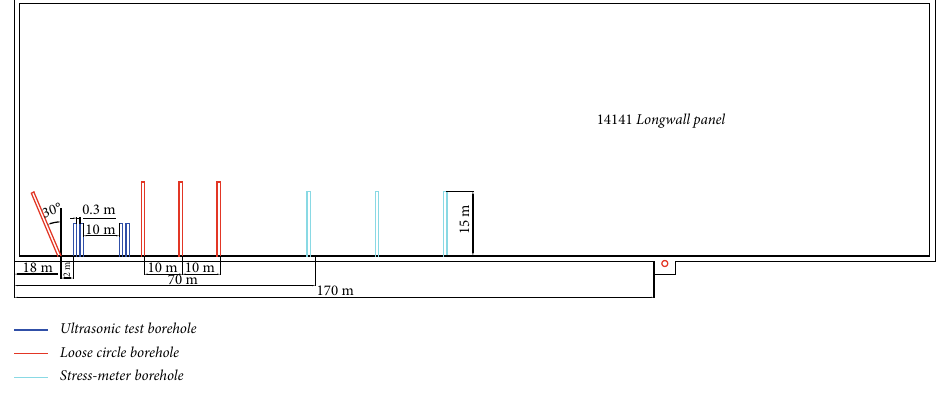
Figure 11: Borehole layout of front abutment pressure.